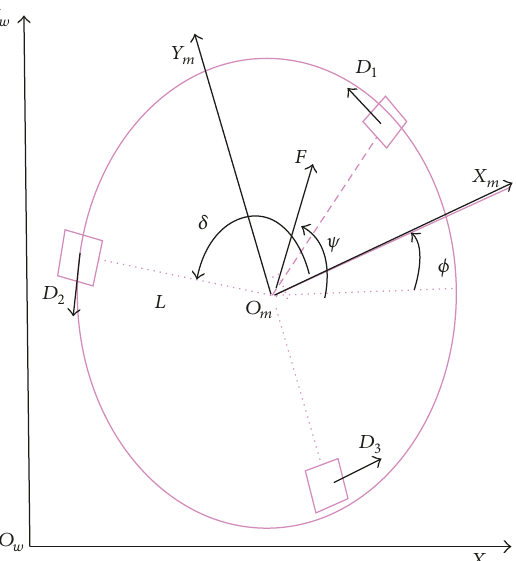
Figure 1: The model of the three-wheeled mobile